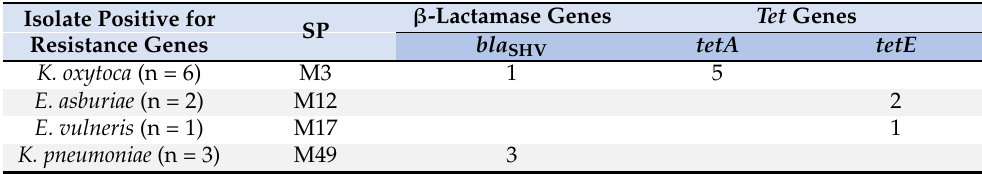
Table 10. Detected resistance genes in resistant coliform bacteria. Isolate Positive for β -Lactamase Genes Tet Genes SP bla Resistance Genes